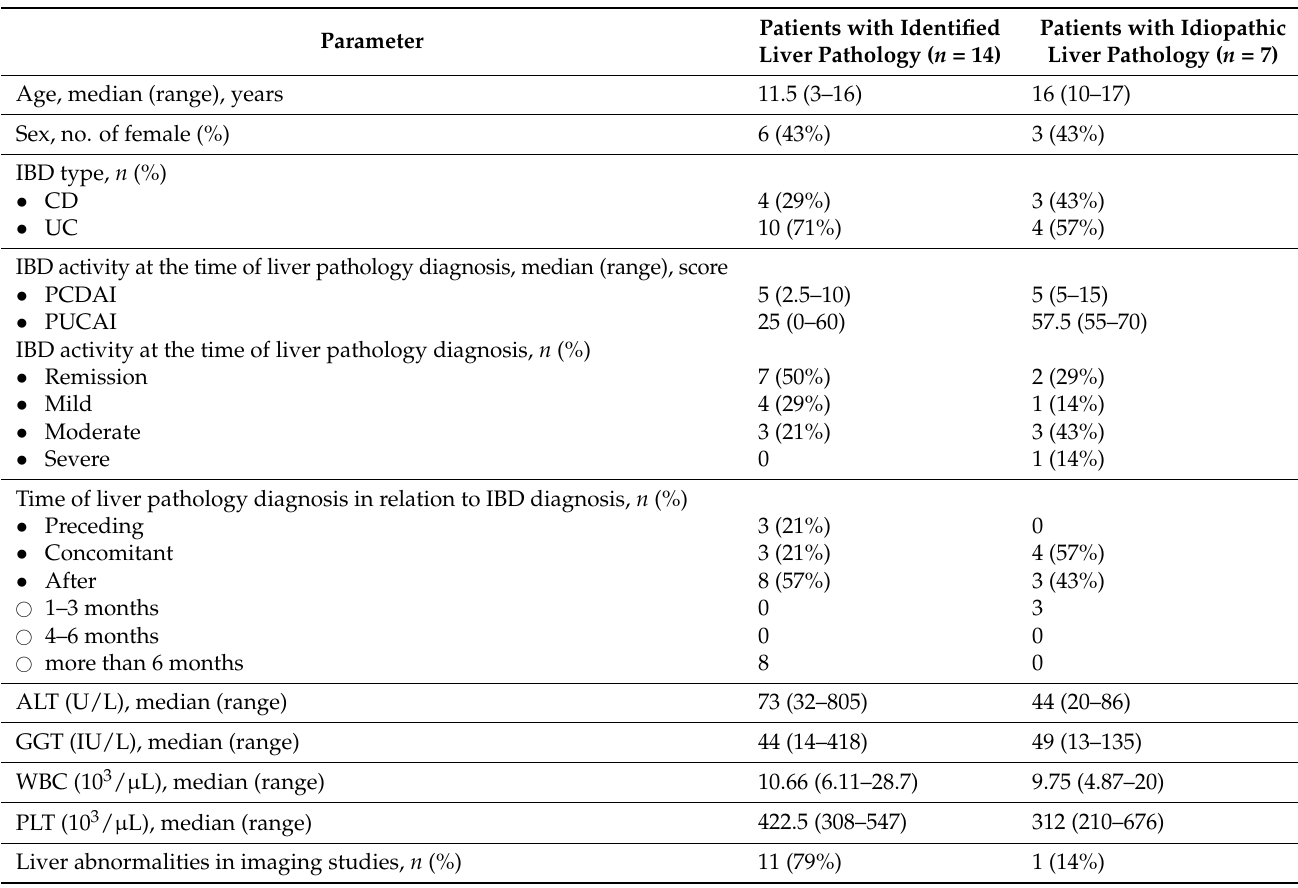
Patients with Identified Patients with Idiopathic Liver Pathology ( n = 14) Liver Pathology ( n = 7)